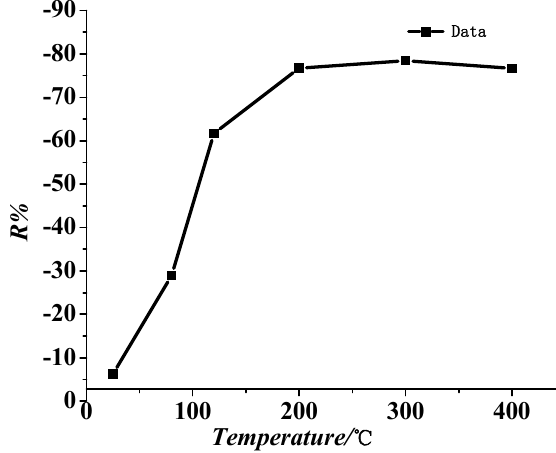
nanotube array sensor at different working temperatures. 2